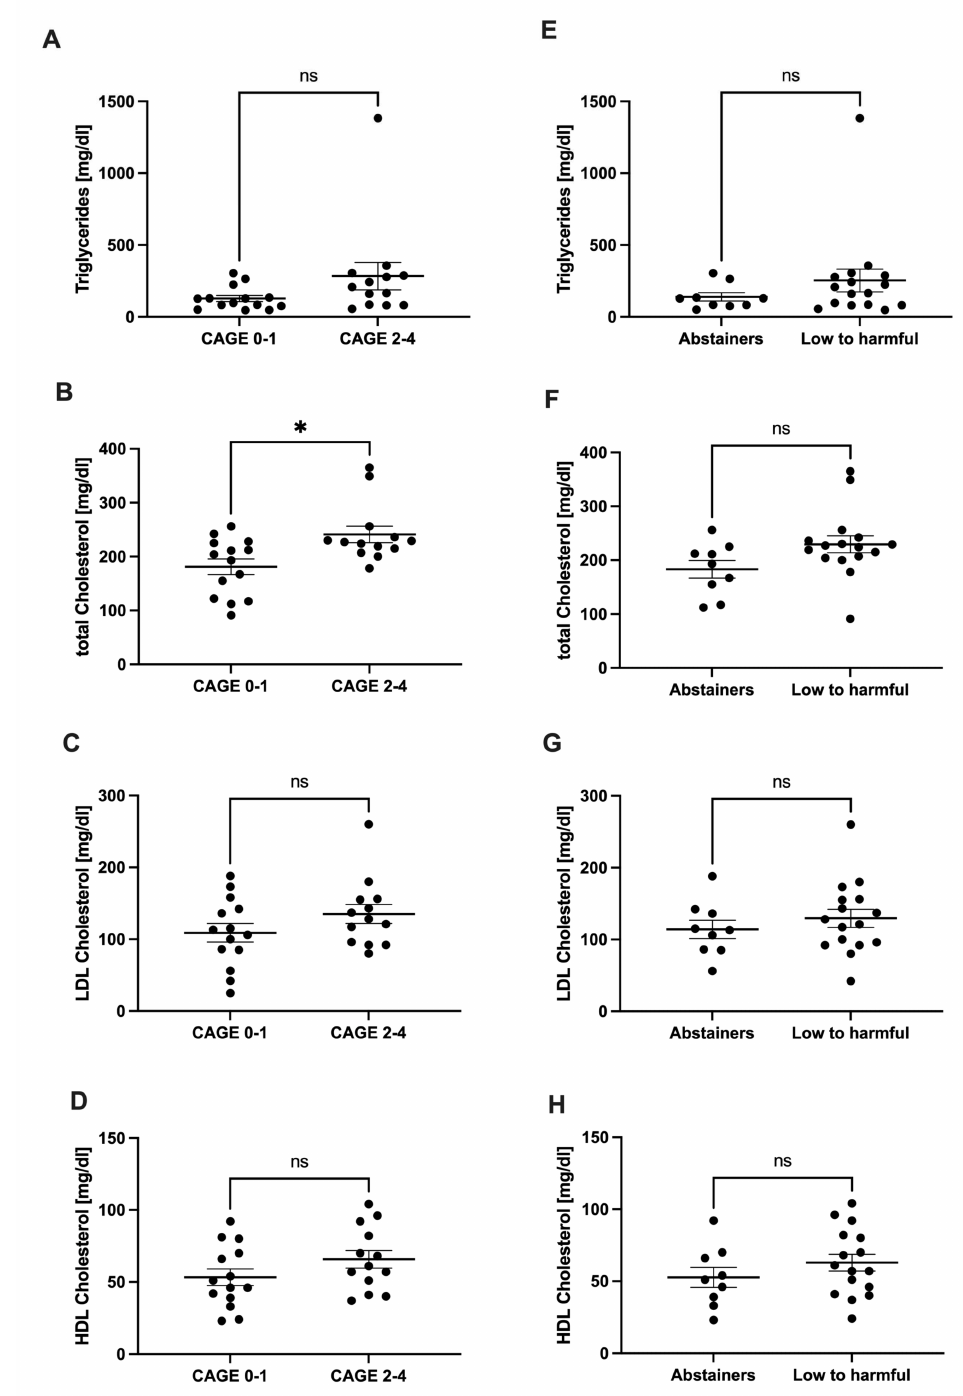
Figure 2. Lipid metabolism. Comparison of serum parameters of lipid metabolism in NASH patients according to drinking history. Levels of triglycerides ( A , E ), total cholesterol ( B , F ), LDL cholesterol ( C , G ), and HDL cholesterol ( D , H ) in CAGE 0–1 versus CAGE 2–4 (CAGE questionnaire) and abstainers versus low to harmful consumers (AUDIT questionnaire). * p < 0.05. ns stands for not